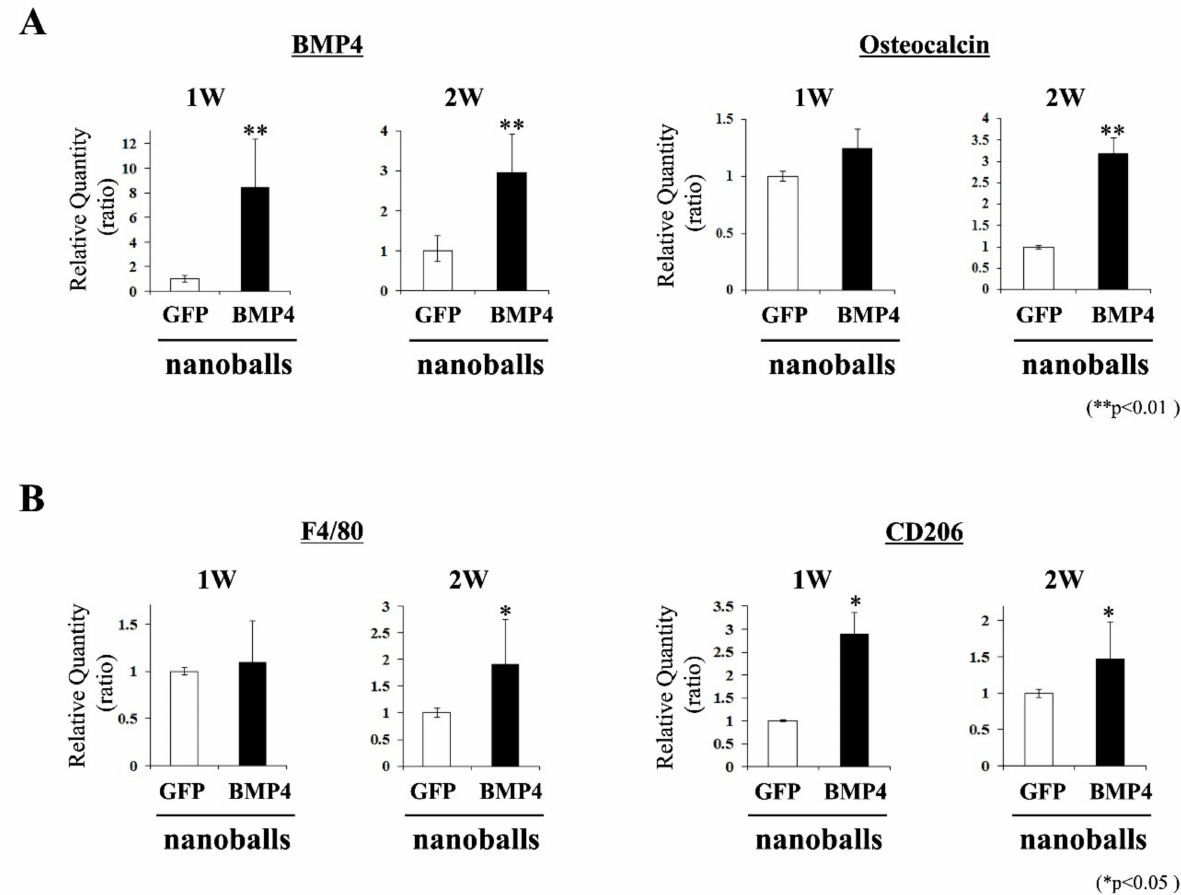
Figure 6. Expression of osteoblast- and macrophage-differentiation genes. ( A ) mRNA expressions of BMP4 and osteocalcin (as markers of osteoblastic differentiation). ( B ) mRNA expressions of F4/80 and CD206 (as markers of M2 macrophages) ( n = 6, * p < 0.05, ** p <